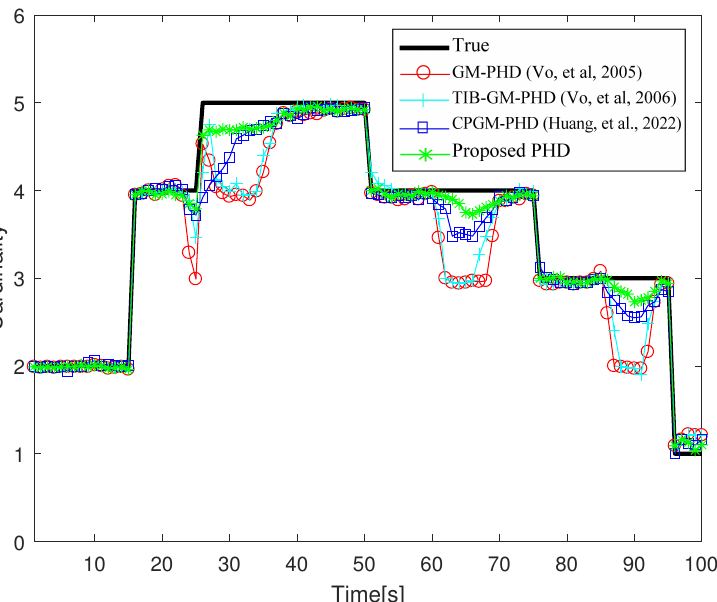
Figure 13. Comparison of cardinality estimates between GM-PHD, TIB-GM-PHD, CPGM-PHD and Proposed PHD (The numbers in brackets represent references to various PHD